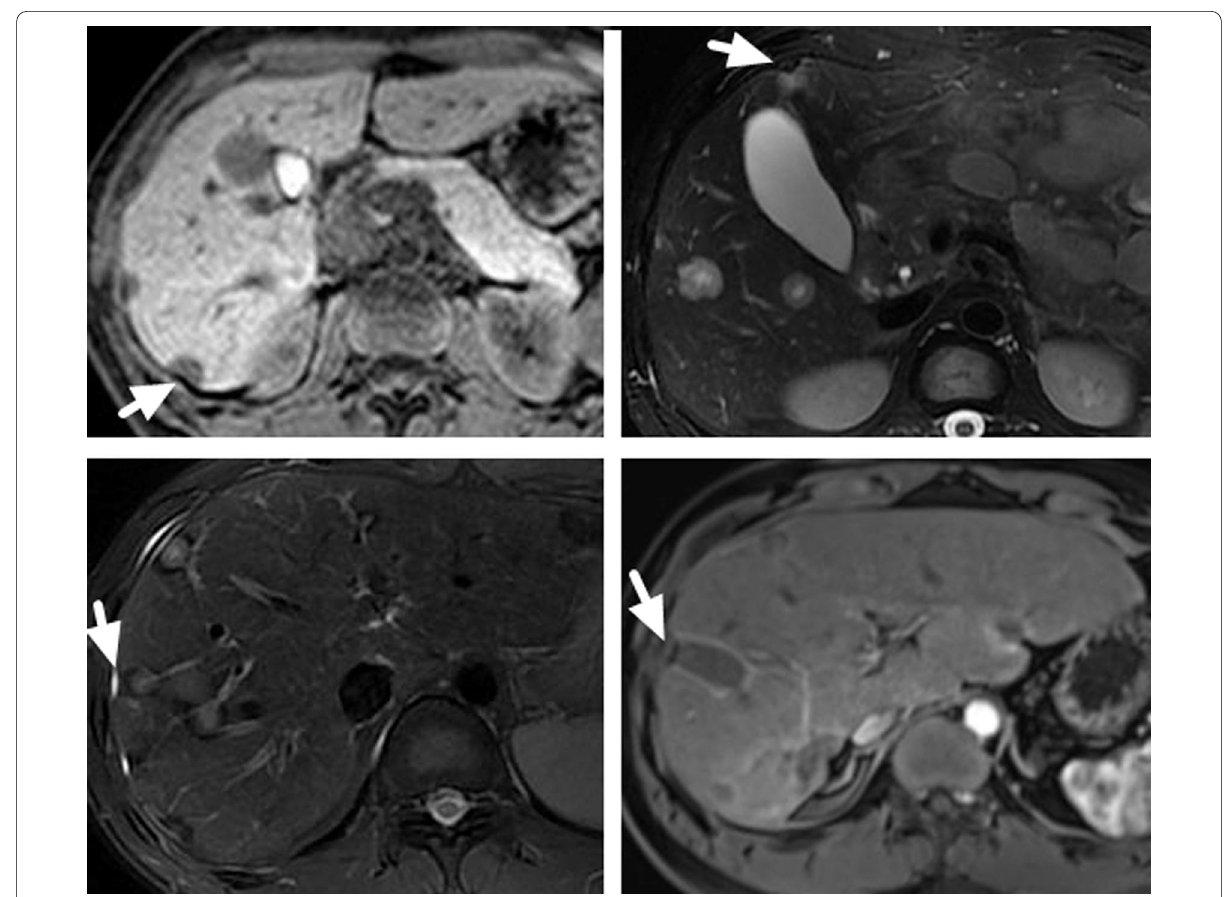
Fig. 6 The appearance of capsular retraction on MRI images of 4 HEH patients